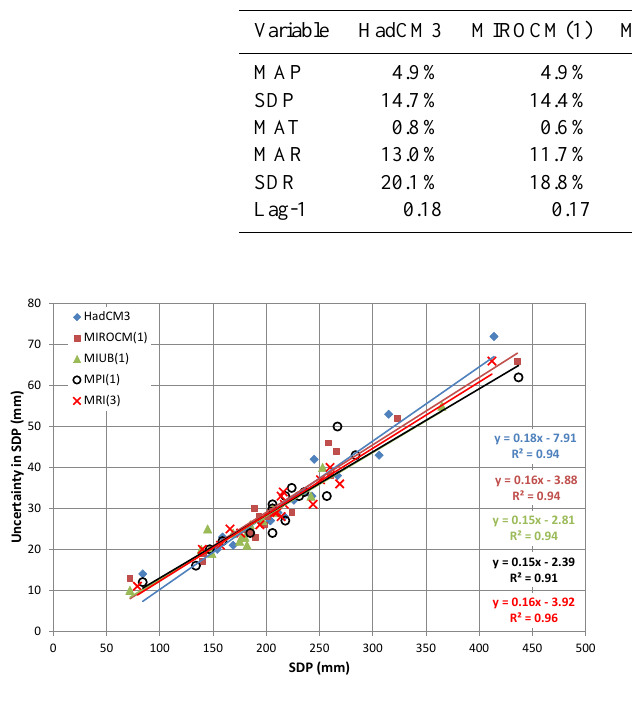
Figure 7. Within-GCM uncertainty (mmyr − 1 ) in standard devi- ation of annual precipitation versus the standard deviation of an- nual precipitation based on 100 replicates of monthly